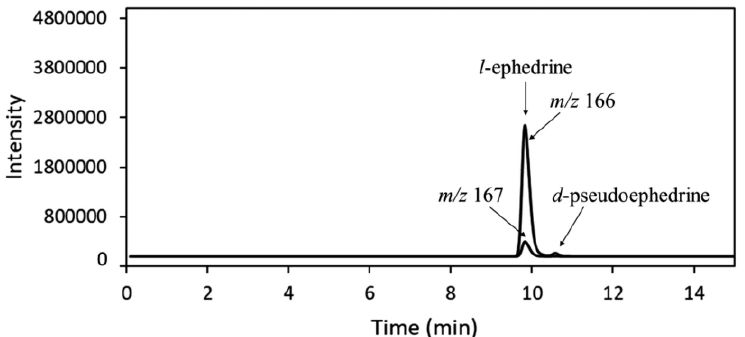
Figure 6. SIM chromatogram of l-ephedrine/HCl [35]. “Reprinted with permission from Ref. [35].